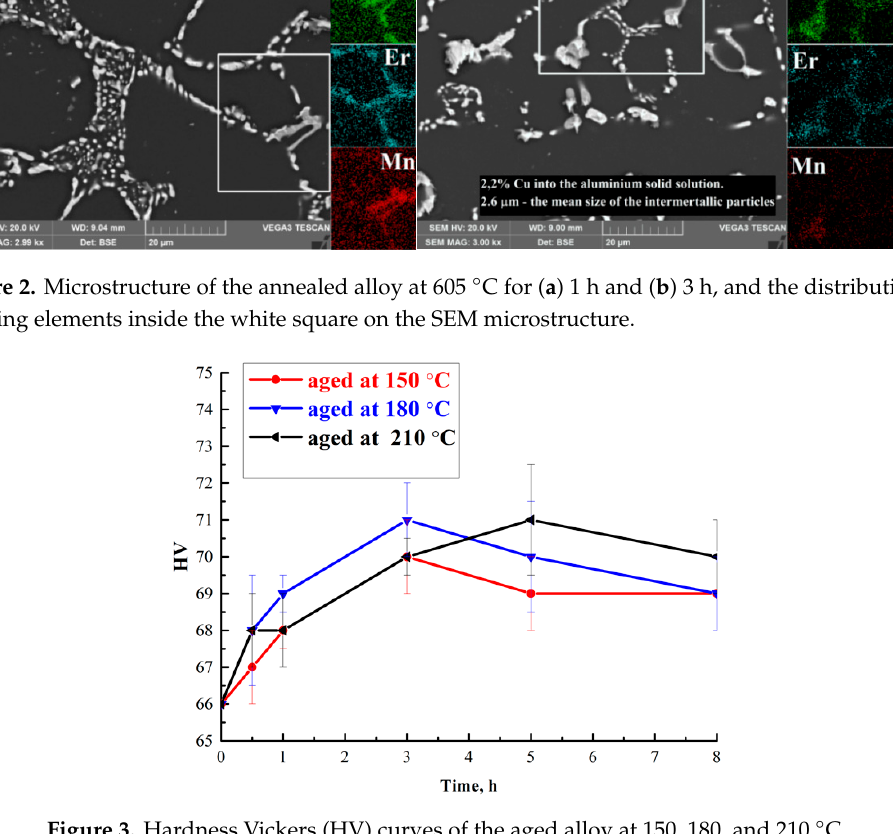
Figure 3. Hardness Vickers (HV) curves of the aged alloy at 150, 180, and 210 °C.